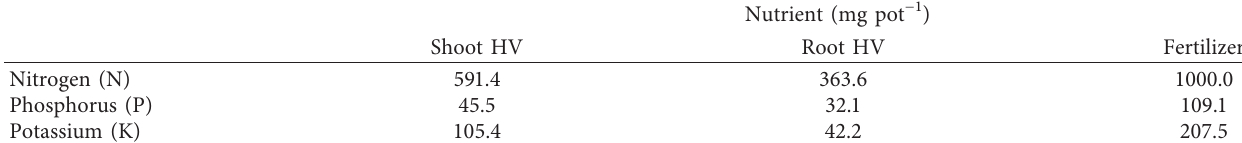
Table 1: Nutrient containing in the hairy vetch (HV) residues and the fertilizer.